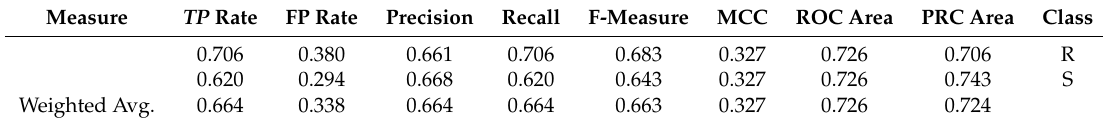
Table 10. Detailed accuracy by class of Multilayer perceptron (10-fold cross-validation).